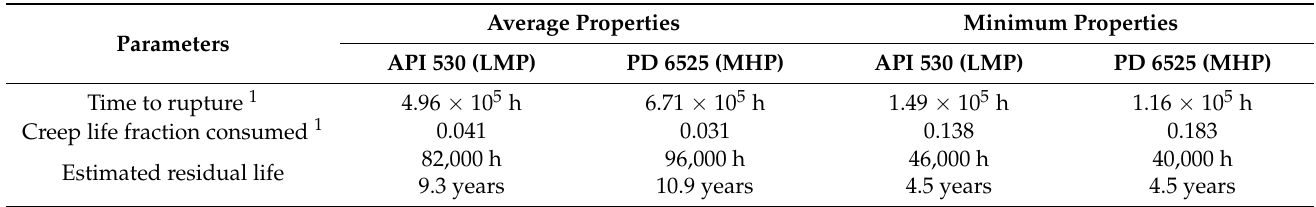
Table 4. Residual life calculation results for L1 from various empirical calculation